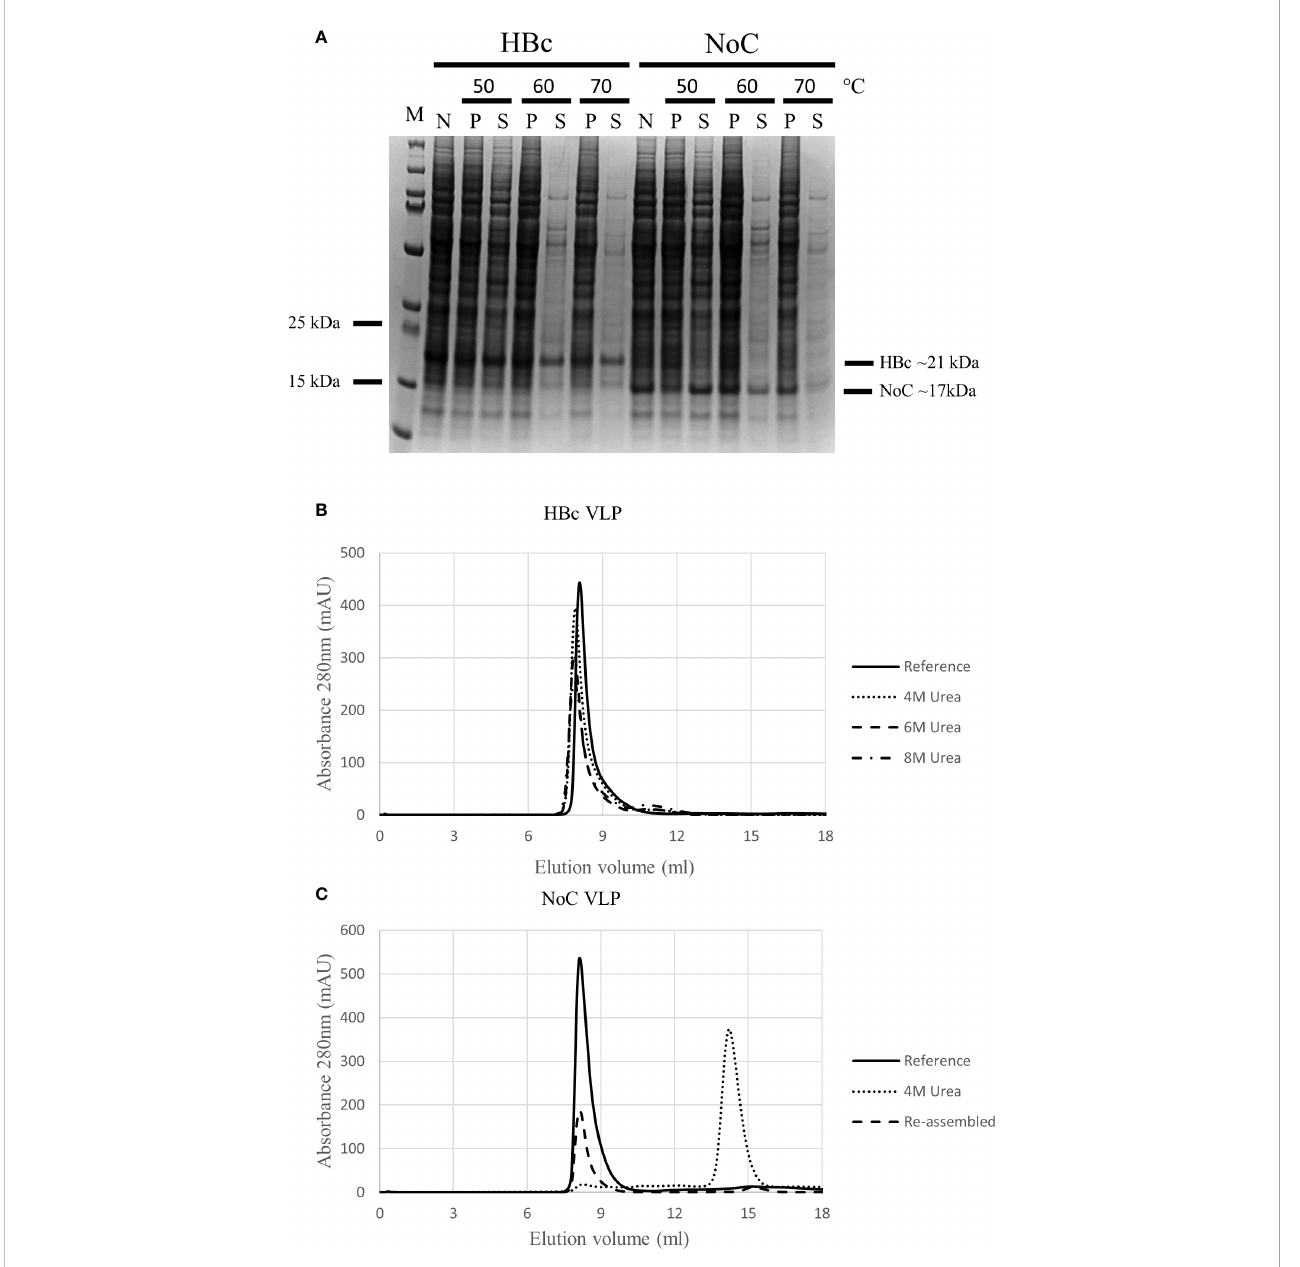
FIGURE 5 Thermal and chemical stability of HBc and NoC VLP particles produced in BYL. (A) Differences in thermal particle stability upon removal of the CTD as shown with SDS-PAGE results after 1 hour heat treatment of HBc and NoC VLP particles at the indicated temperatures. (B) Differences in chemical particle stability as shown using size exclusion chromatography of HBc VLP particles treated with the indicated urea concentrations and 1mM DTT. Reference indicates behavior for un-treated HBc VLP (C) Disassembly of NoC VLP particles treated with 4M urea and 1mM DTT and re-assembled in 50mM Tris-HCl (pH 7) + 800mM NaCl as shown by size exclusion chromatography. M, molecular weight marker; N, non-heat-treated; P, pellet after heat treatment; S, supernatant after heat treatment; HBc, hepatitis-B core antigen; NoC, HBc core antigen lacking the C-terminal domain; S, Strep insert, located either at N-terminus or spike of the HBc and NoC